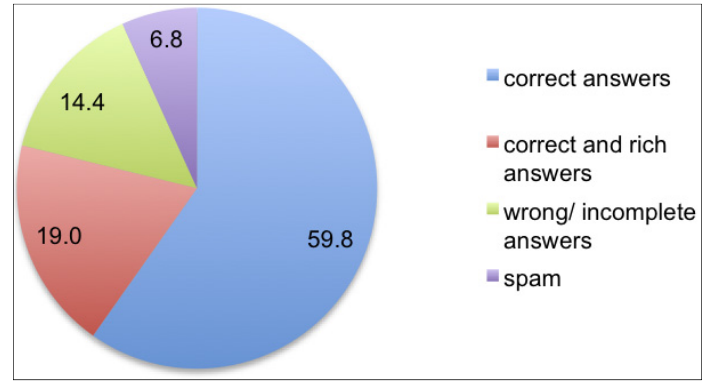
Figure 4 . Correct, rich, incorrect/incomplete and spam answers in the set